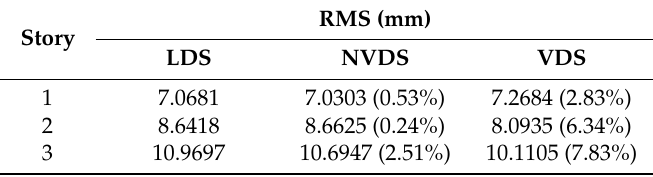
Figure 7. Dynamic displacement comparison between LDS, NVDS and VDS. ( a ) 1st floor, ( b ) 2nd floor, ( c ) 3rd floor. Table 1. Displacement data reliability results in the white noise test.